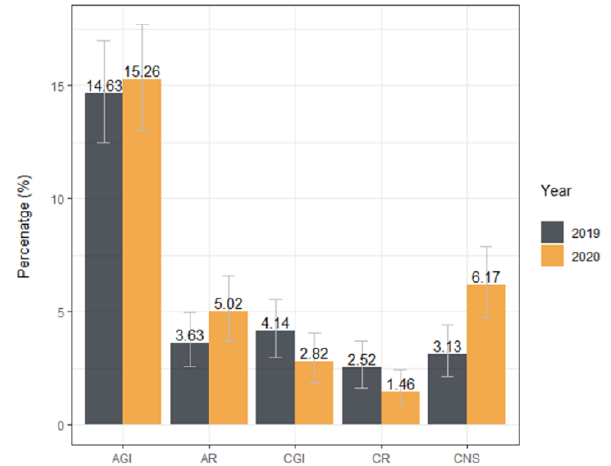
Figure 2. Prevalence of specific diagnosis at dogs admitted to the Veterinary Teaching Hospital in 2019 and 2020. Other diagnoses are not shown in this figure. Error bars represent a 95% confidence